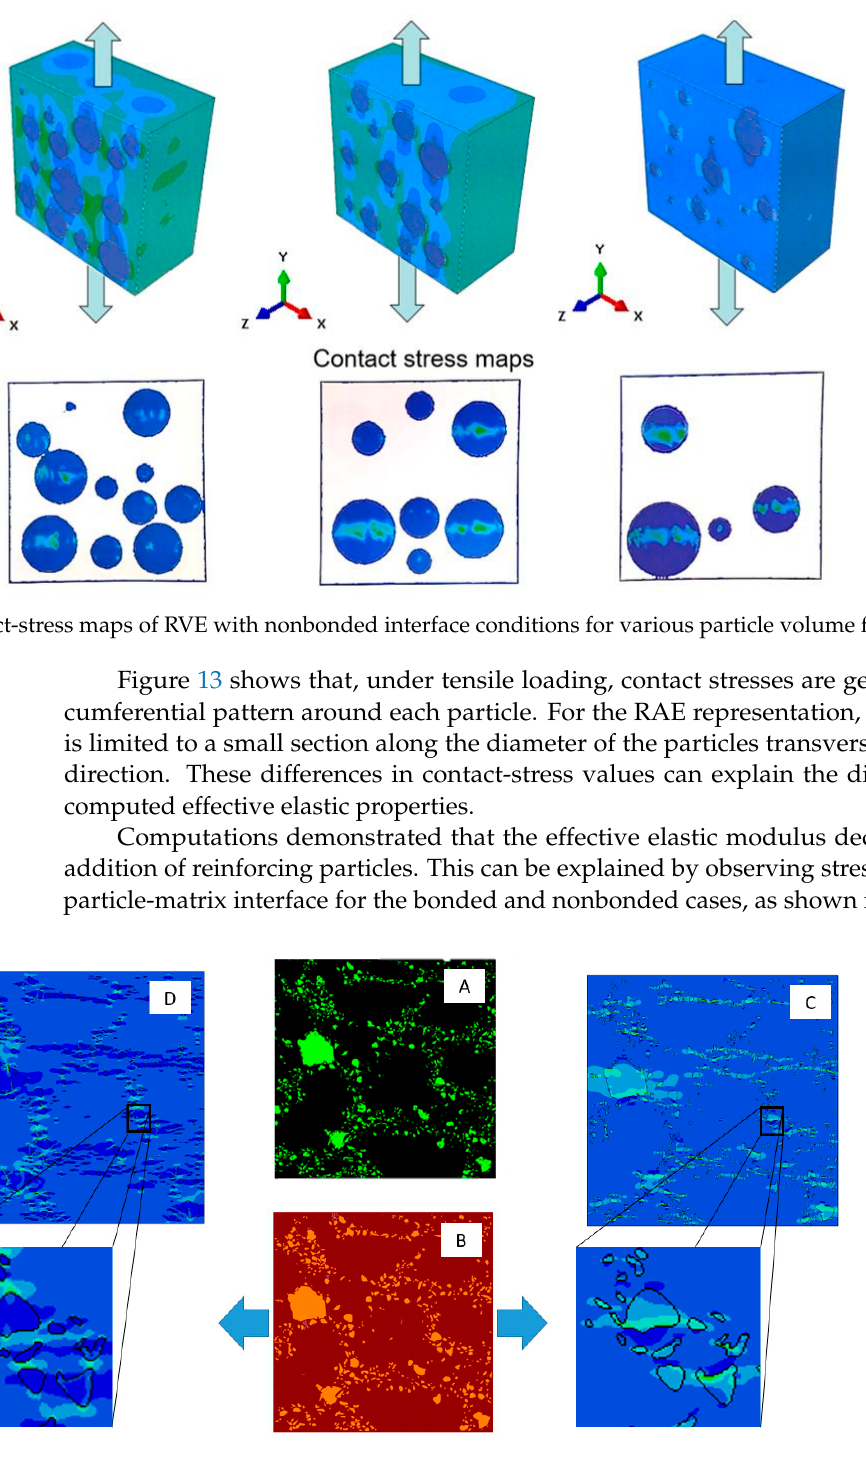
( b ) Figure 12. Comparison between measurements (compression testing) and predicted (RAE compu- tations under compression loading) relative effective elastic modulus ( a ) and Poisson’s ratio ( b ) for different particle volume fractions. 5. Discussion As discussed in the introduction, most studies that investigate the mechanical re- sponse of AMCs at the microscale employed 2D unit cell representations. The obtained results in this study demonstrate that this assumption is valid, even in the elastic loading